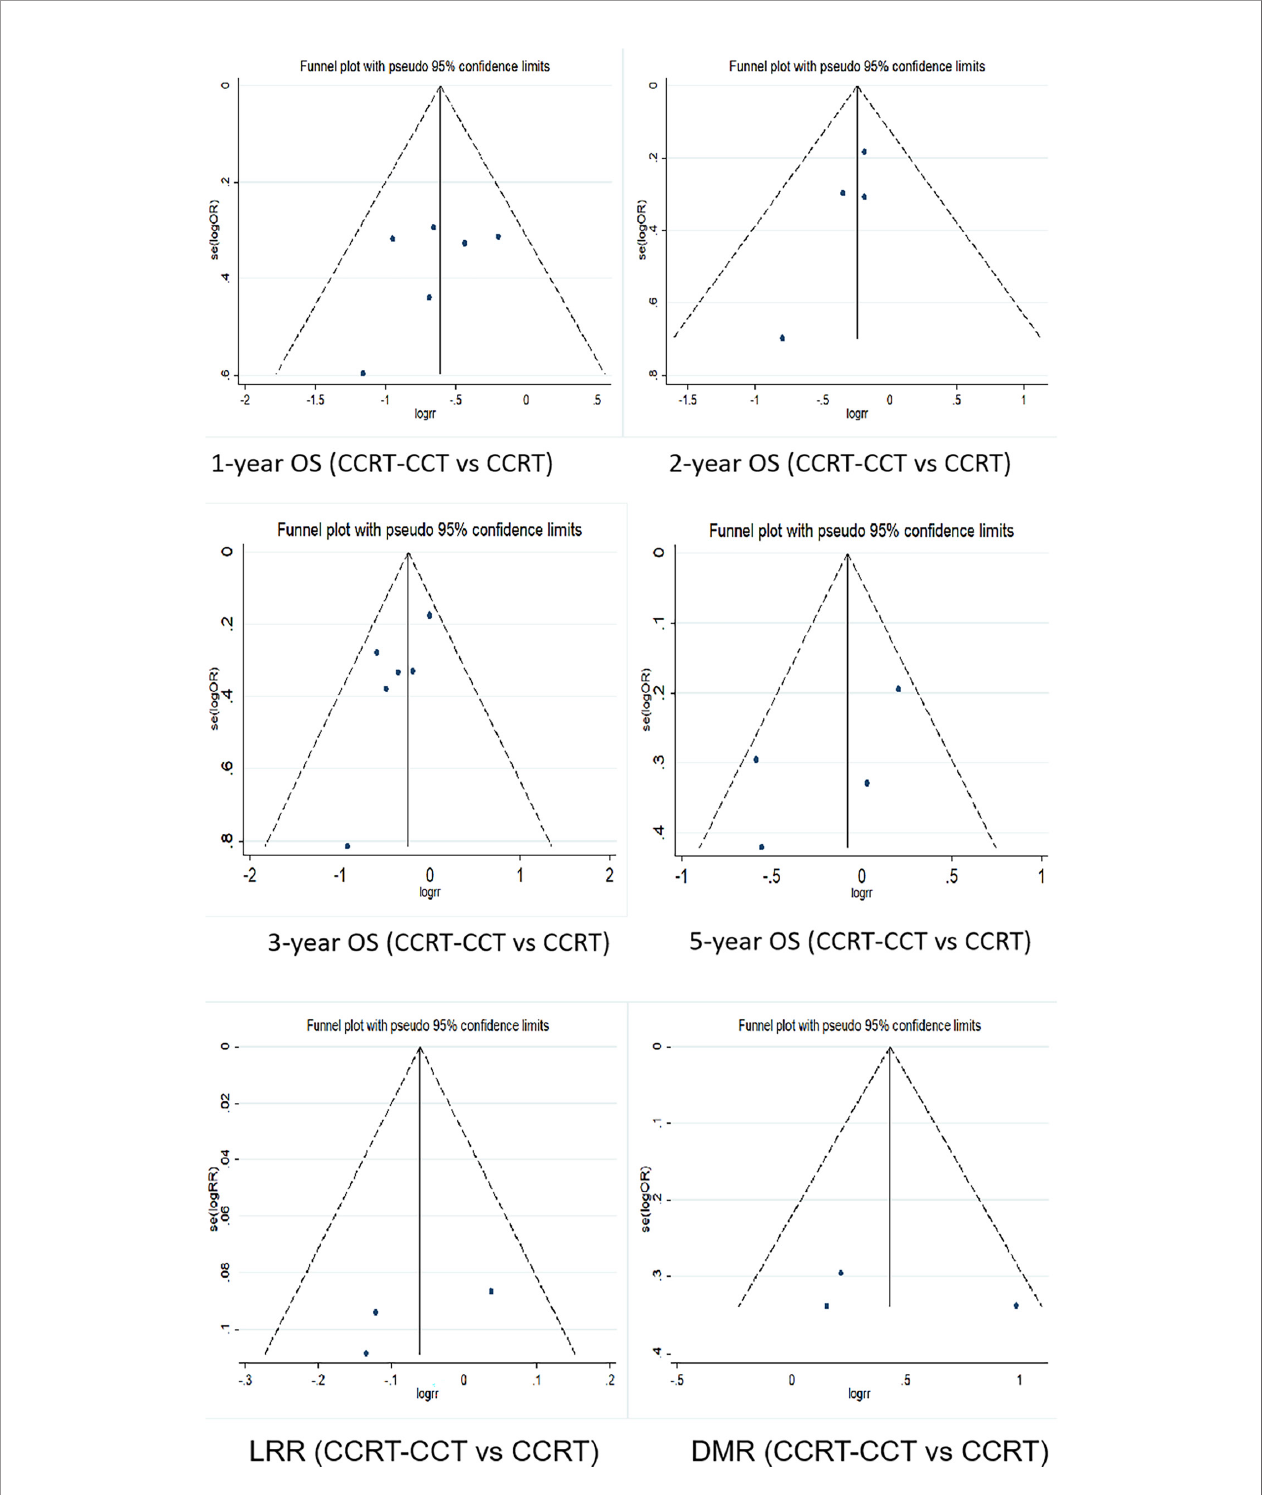
FIGURE 6 | Funnel plots for 1-, 2-, 3-, and 5-year OS rate, LRR, and DMR between CCRT-CCT group and CCRT alone group. OS, overall survival; LRR, local recurrence rate; DMR, distant metastasis rate; CCRT-CCT, concurrent chemoradiotherapy followed by consolidation chemotherapy; CCRT, concurrent